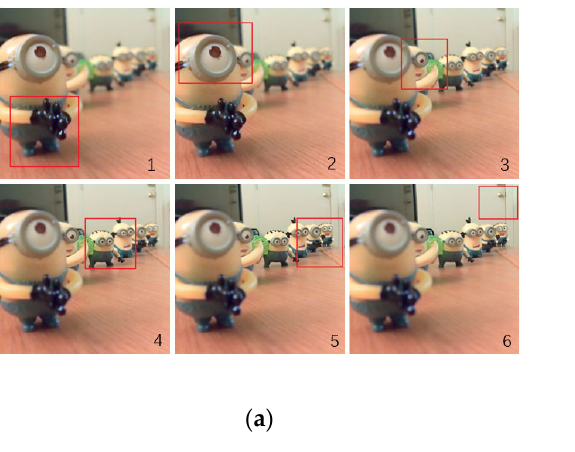
Figure 2. ( a ) Focus ‐ stacked images. ( b ) All ‐ in ‐ focus images.